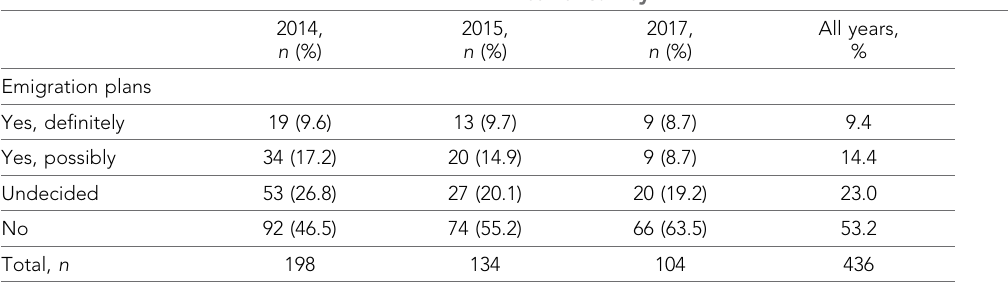
Table 3. Emigration plans of recent GP graduates who currently reside in Ireland.